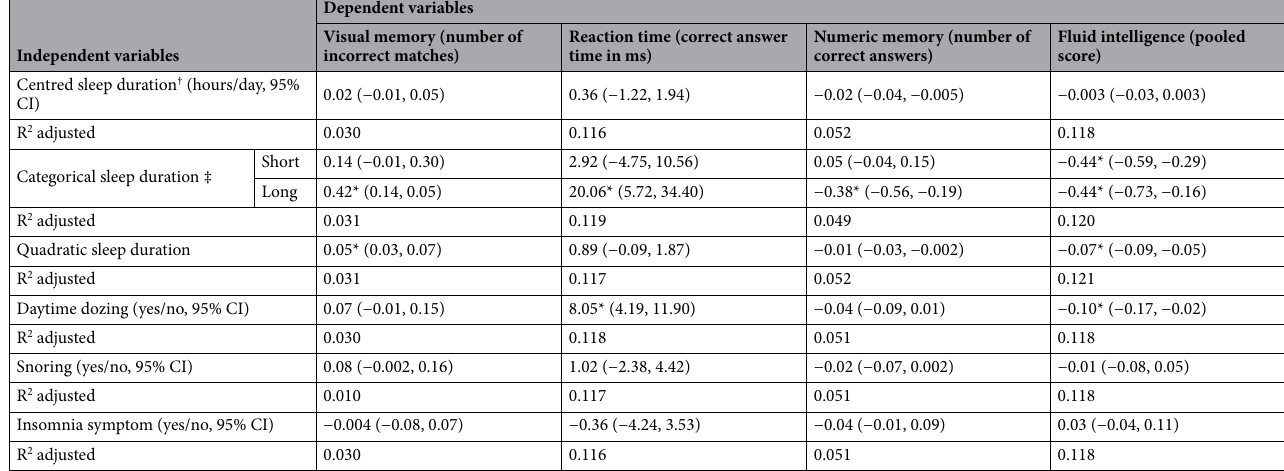
Table 2. Association between cognitive functions and self-reported sleep duration (n = 14,206). The estimates are controlled for the following covariates: age, sex, education, body mass index, smoking, alcohol,